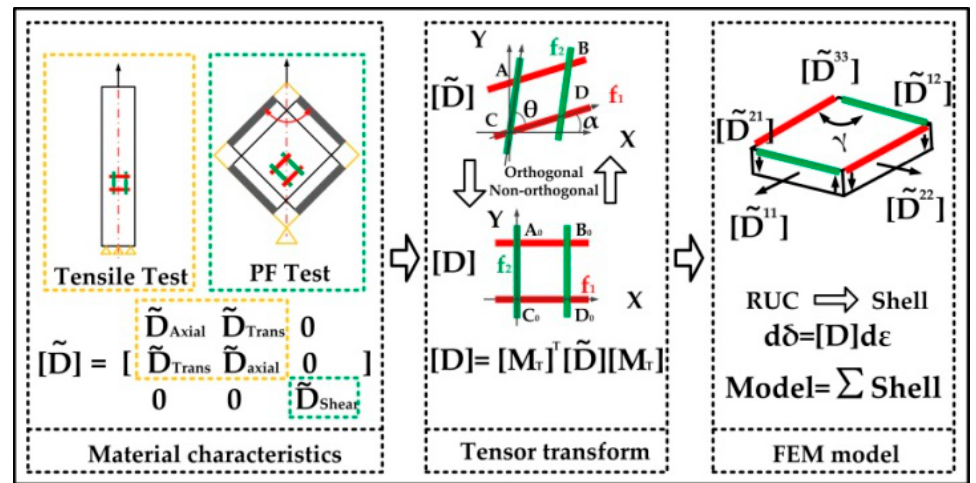
Figure 2. The modeling process.